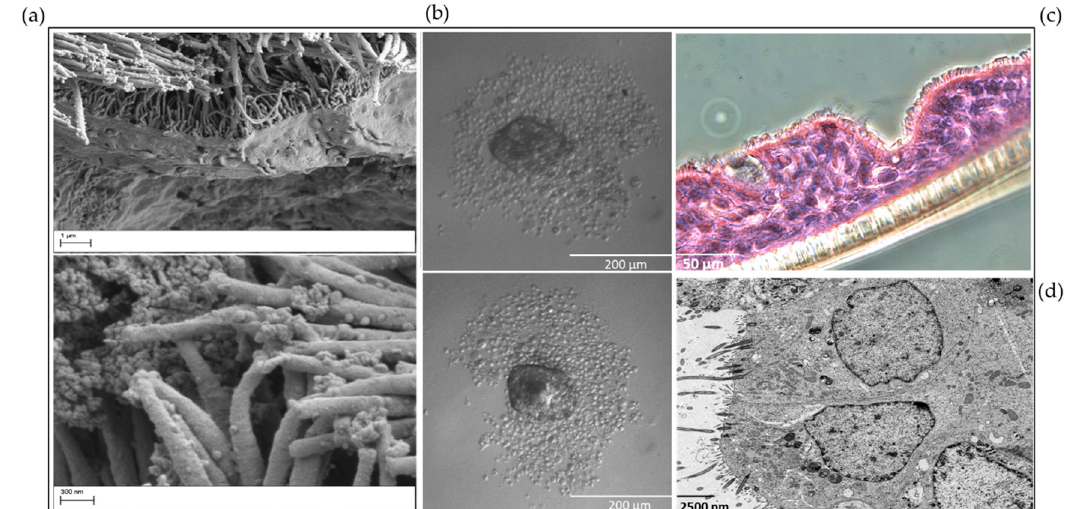
Figure 3. The morphology of nasal epithelial cells. ( a ) Scanning electron microscopic imaging of organotypic 3D nasal epithelial cell cultures derived from young children with asthma or healthy subjects (left top: ×4.00 K; left bottom: ×9.45K, in different sizes). These images show the morphology of the nasal epithelial cell culture with cilia, the integrity of the cell–cell-interaction, and the glycocalyx structure. The samples were prepared for imaging with Zeiss Sigma VP SEM (Zeiss, Oberkochen, Germany) scanning electron microscope at 2 kV acceleration voltage using the in-lens and SE detectors. ( b ) Nasal epithelial cells were seeded for the submerged spheroid culture technique. Cells derived from a healthy subject were seeded in a 96-well plate at circa 1000 cells per well in U-Bottom plate (x10 magnification, size 200 µm) receiving PneumaCult TM ALI medium (STEMCELL TM Technologies, Vancouver, Canada). After reaching a determined cell size, the spheroid culture can be used for distinct experimental questions. This experiment was separately performed and correlates thematically with [22]. ( c ) ALI culture derived from a healthy subject. After passaging nasal epithelial cells from the 2D submerged into the organotypic 3D ALI culture model, samples were prepared for histological analyses. This figure presents the cilia morphology of the cultures and the cell–cell integrity in PAS reaction. The ciliary epithelium is precisely imaged (×10 magnification, size 50 µm). ( d ) Transmission electron microscopic (TEM) analysis of nasal epithelial ALI cultures (×20,000 magnification, size 2.500 µm). The aim of this additional method and figure is to present the cell–cell–contacts (tight junctions), cilia and organelles through TEM to study the effectiveness of the cell culture model. These methods/pictures were separately performed, correlate thematically with [22] and were not previously published else- where.